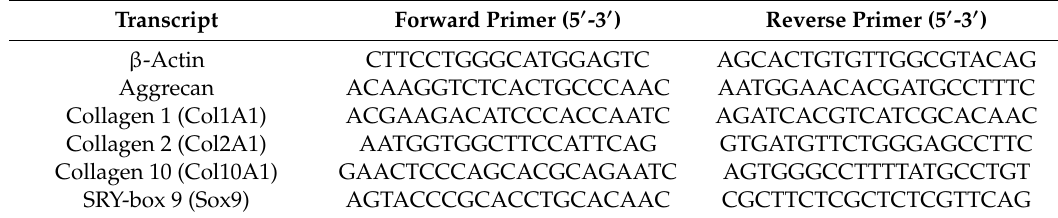
Table 2. Primer sequences for